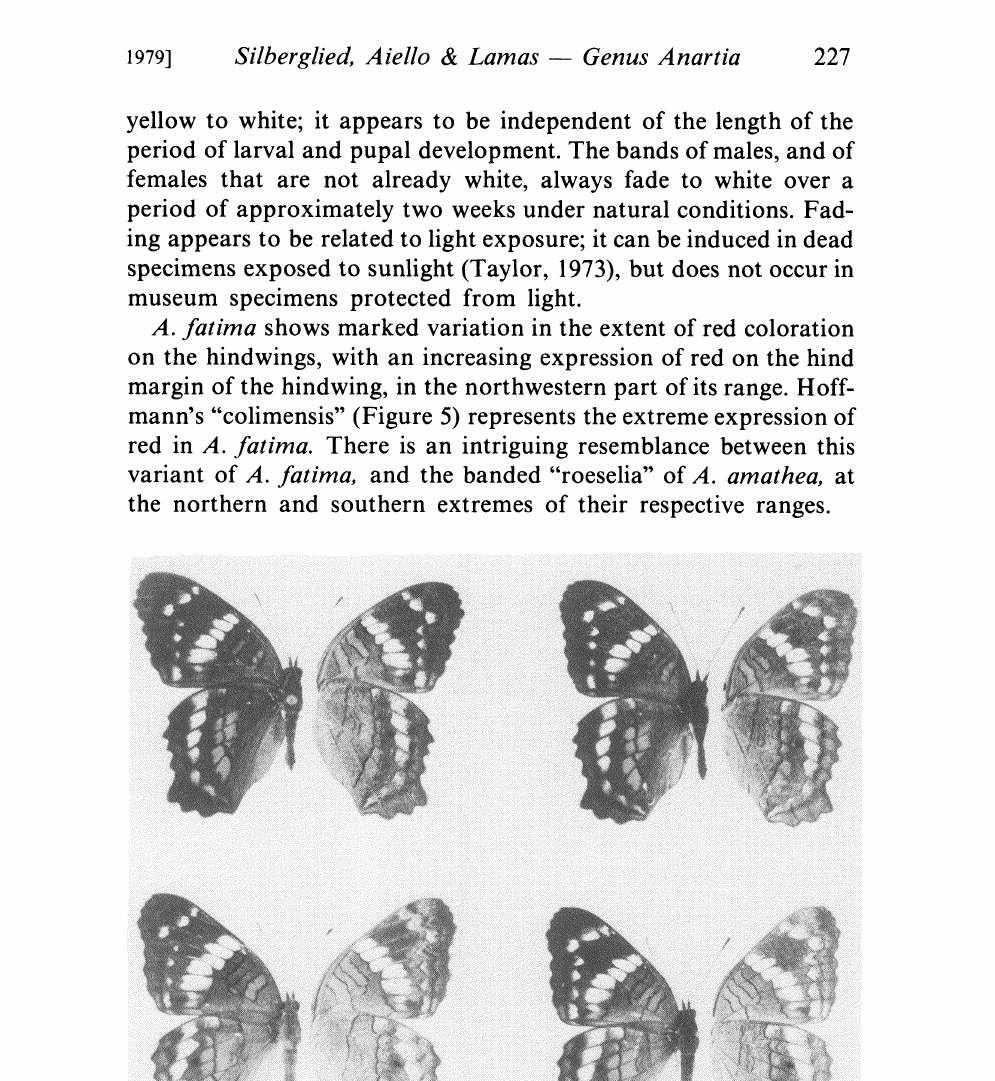
Figure 4. F1 hybrids of A. amathea and A. fatima; male above, female below. Reared on Blechum brownei at Barro Colorado Is., Panamt. Left: A. amathea female x A. fatima male: male AF-17, 1977; female AF-160, 1976. Right: A. fatima female x A. amathea male: male FA-151, 1976; female FA-274,